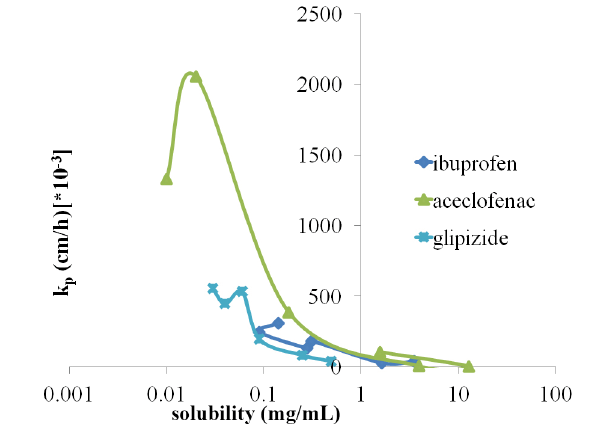
FIGURE 2 - Solubility vs. Kp of weakly acidic drugs.